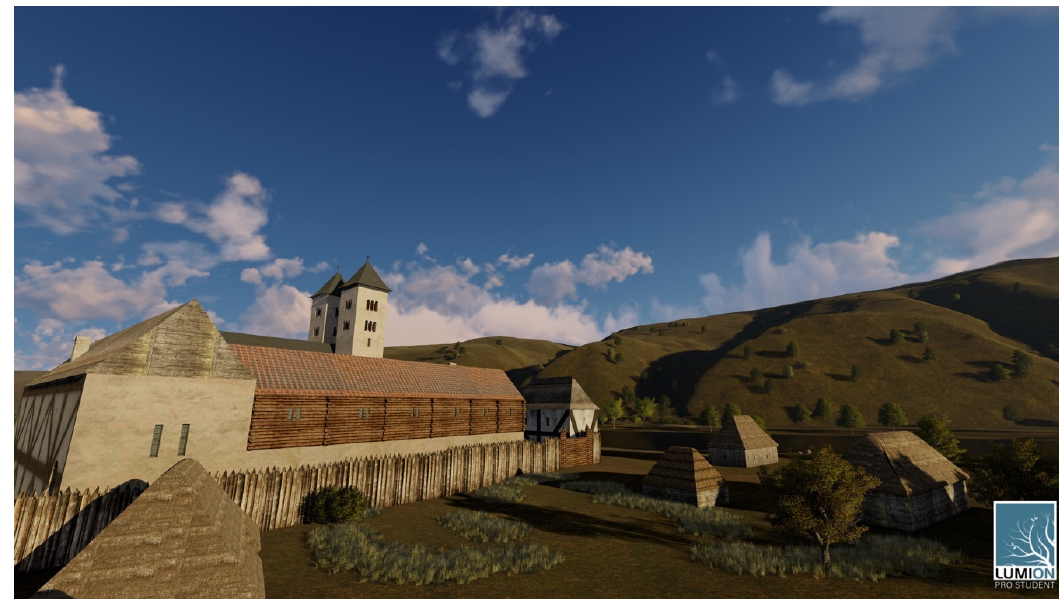
Figure 10. Visualization of the monastery in the Romanesque era in the summer season.